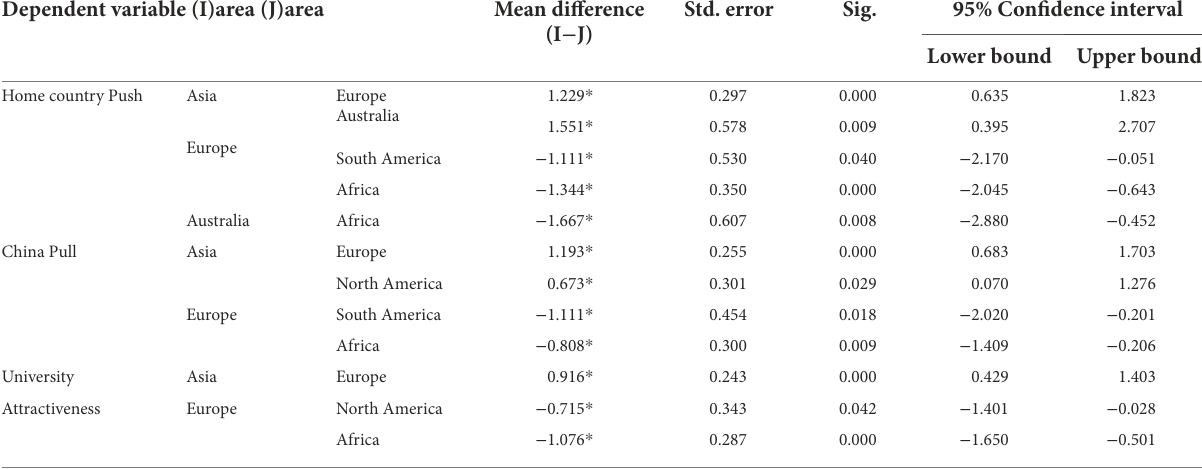
TABLE 3 The regional difference of influencing factors for international